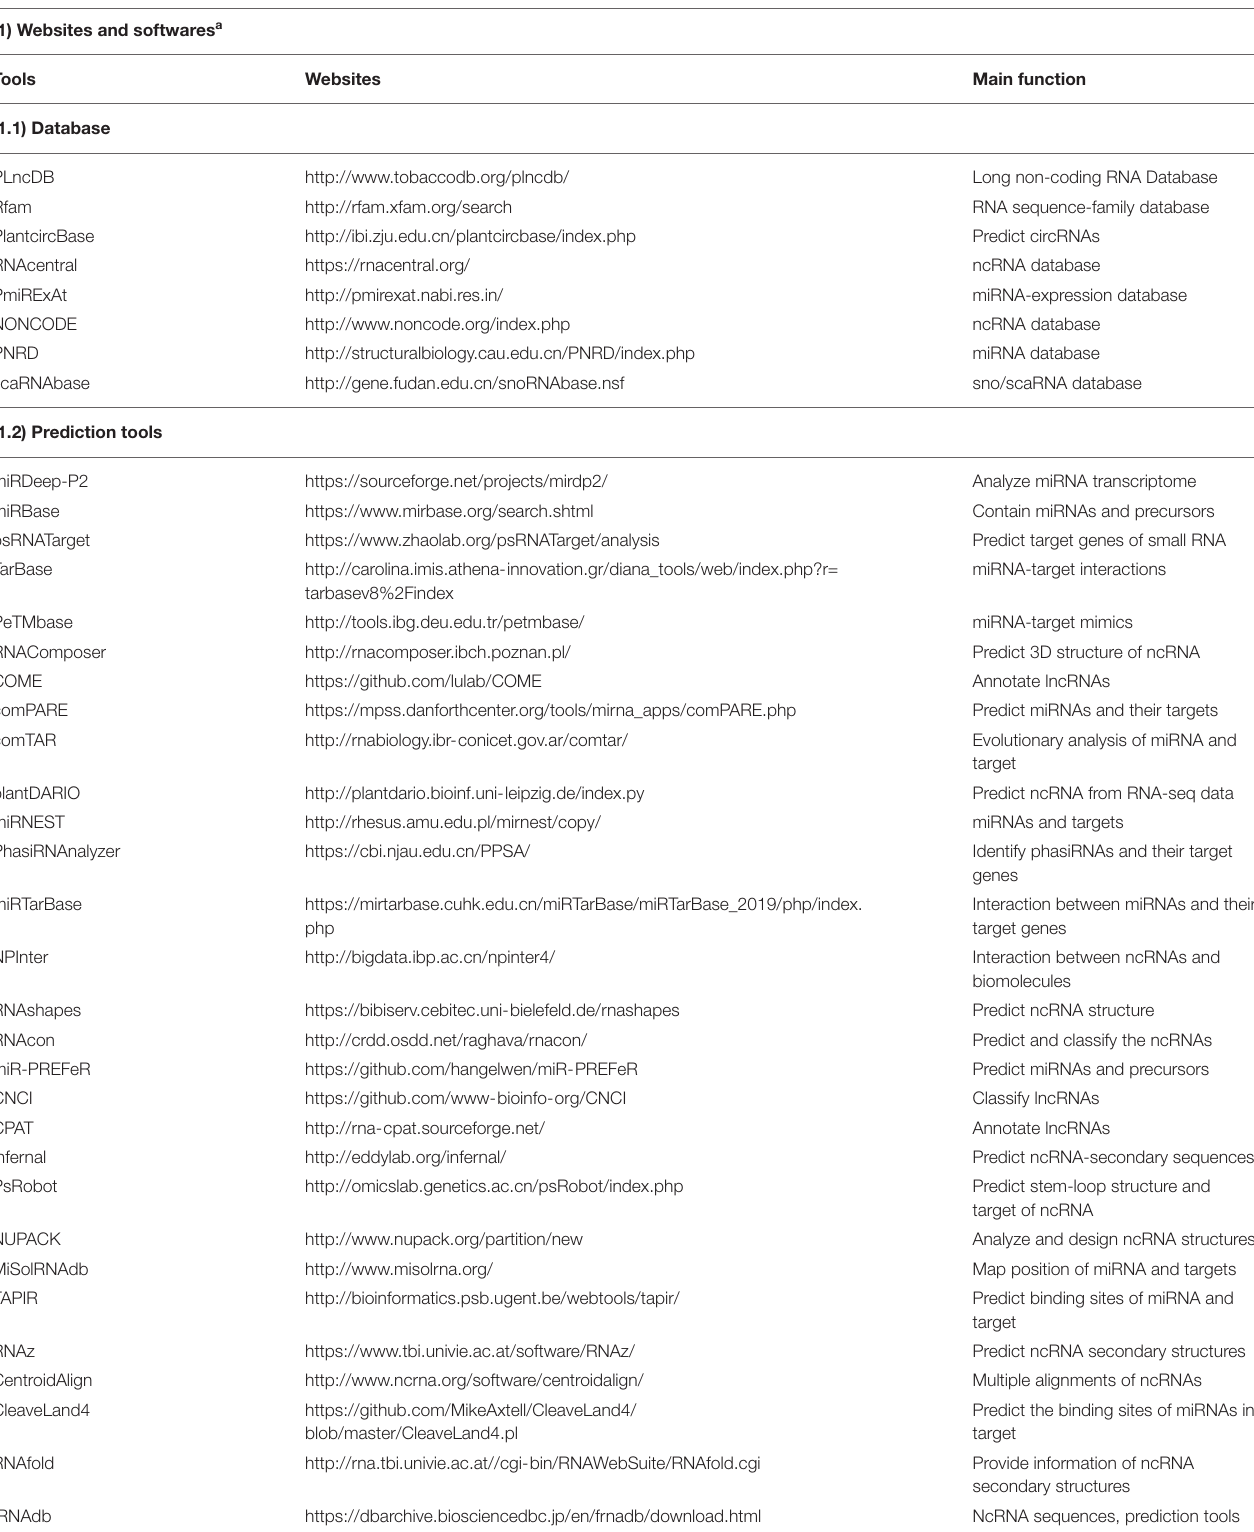
TABLE 1 | Bioinformatics tools in ncRNAs analysis. (1) Websites and softwares